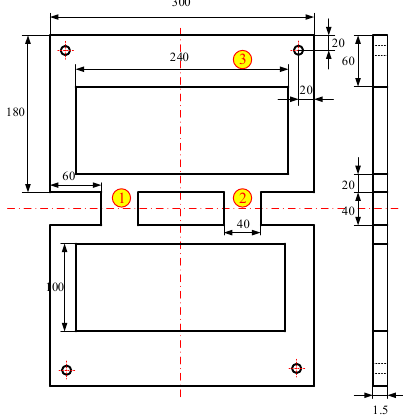
Figure 13. Dimension of the aluminum solar panel frame.